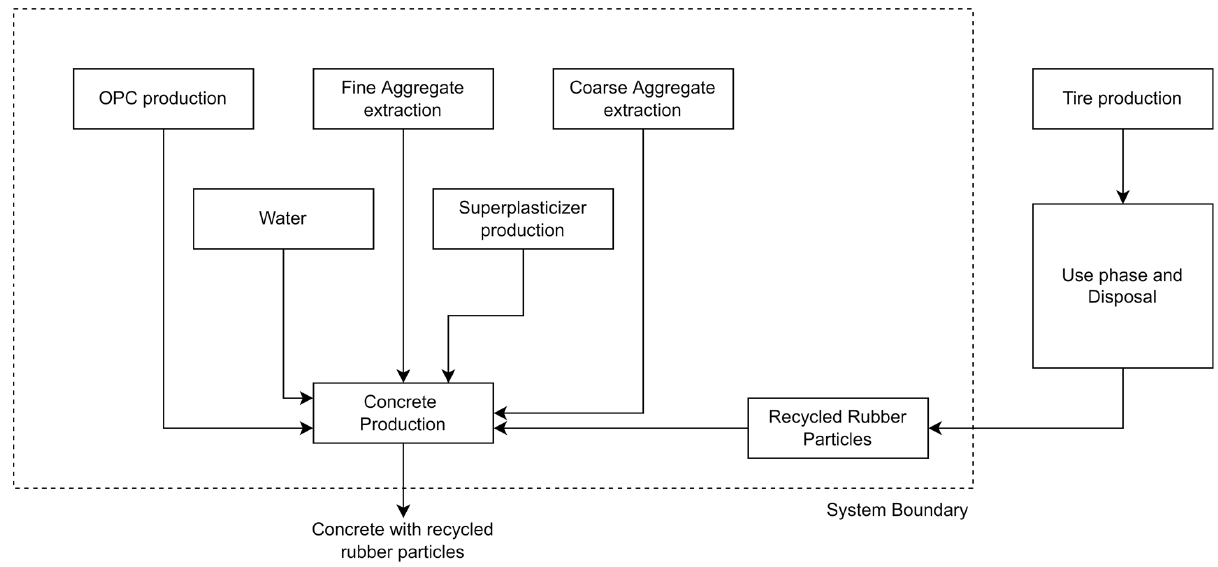
Figure 8. System boundary for mixes using recycled rubber.